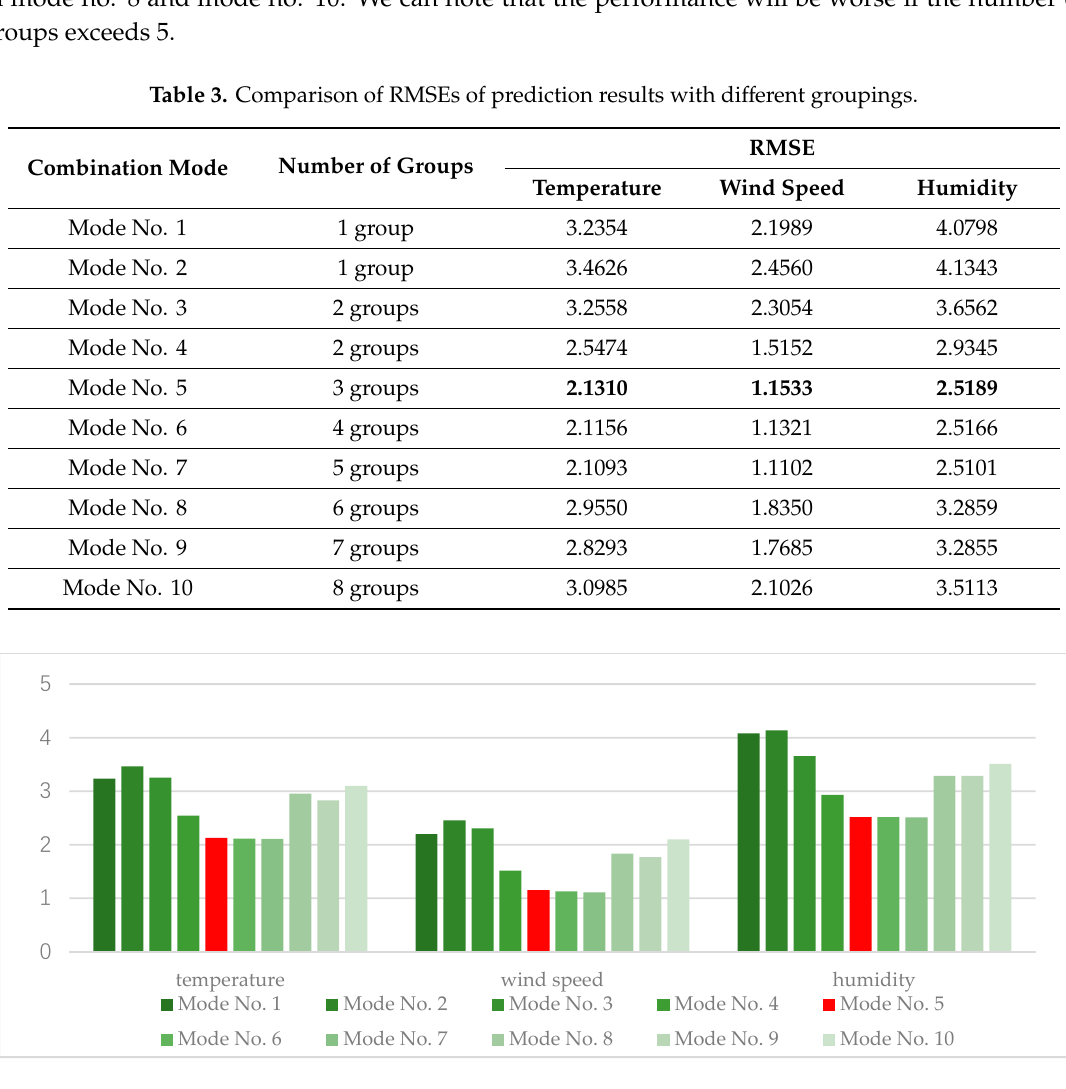
Figure 11. Histogram of numerical comparisons of RMSEs for different combination modes.